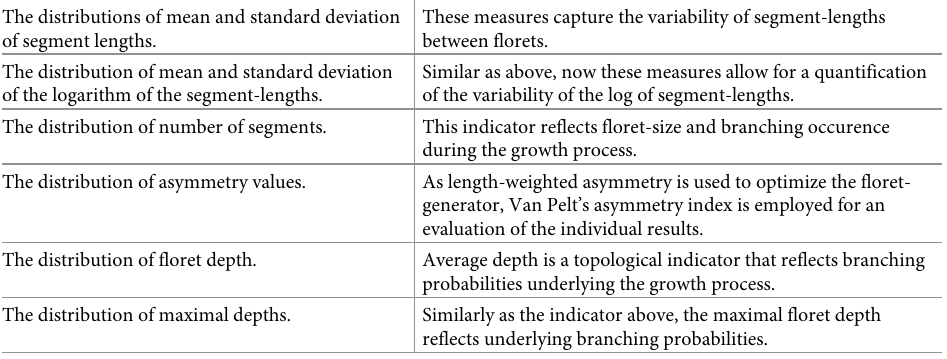
Table 1. Evaluation criteria for individual generated florets. The distributions of mean and standard deviation These measures capture the variability of segment-lengths of segment lengths. between florets. The distribution of mean and standard deviation Similar as above, now these measures allow for a quantification of the logarithm of the segment-lengths. of the variability of the log of segment-lengths. The distribution of number of segments. This indicator reflects floret-size and branching occurence during the growth process. The distribution of asymmetry values. As length-weighted asymmetry is used to optimize the floret- generator, Van Pelt’s asymmetry index is employed for an evaluation of the individual results. The distribution of floret depth. Average depth is a topological indicator that reflects branching probabilities underlying the growth process. The distribution of maximal depths. Similarly as the indicator above, the maximal floret depth reflects underlying branching probabilities. The criteria capture metric (segment-length) and topological (asymmetry, depth) properties, as well as floret size (number of segments). These criteria are not employed for the optimization of the floret-generator.